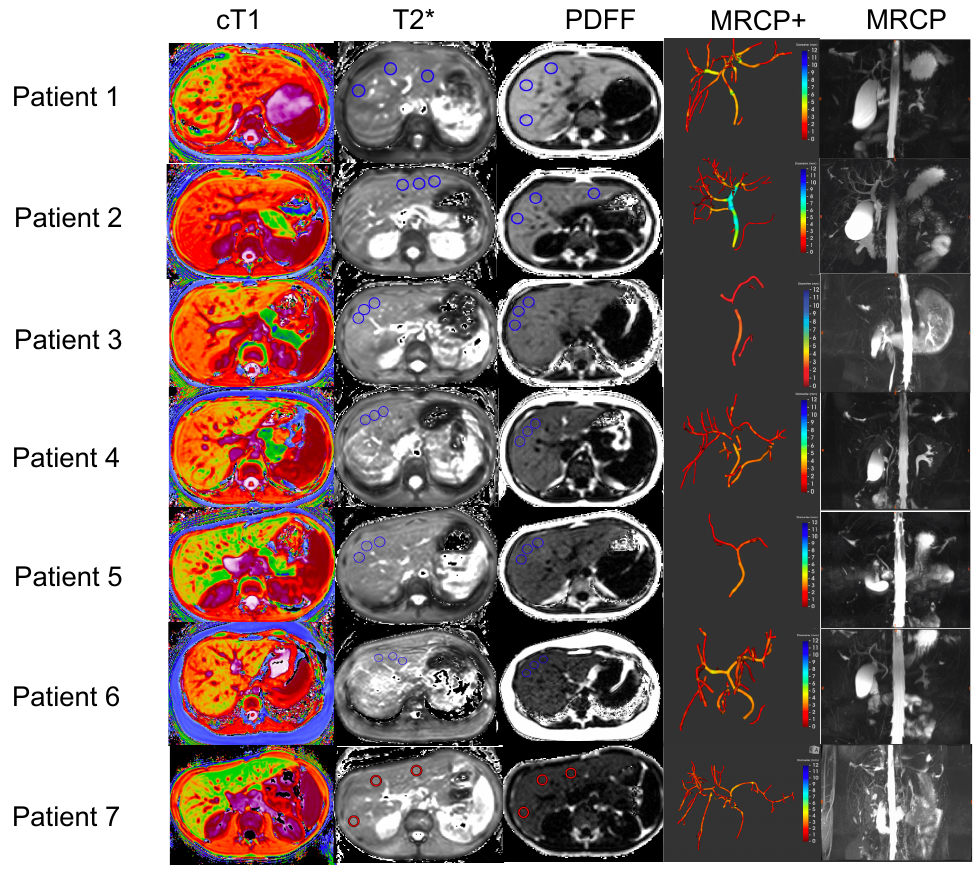
Figure 1. Representative biliary tree models, and cT1, T2*, and PDFF maps from all Wilson’s disease patients recruited in this study. In addition, the MRCP+ models of the biliary tree and the original MRCP images are also shown for each patient. In the cT1 maps, lower values (cooler colors) represent areas with lower cT1 values, and therefore, lower fibro − inflammation, whereas higher cT1 values (warmer colors) represent areas of the liver with higher fibro − inflammation. In the MRCP+ images, strictures are shown in red, whereas dilatations are shown in blue. cT1: corrected T1; PDFF: proton density fraction (MRI liver fat); magnetic resonance cholangiopancreatography (MRCP); quantitative magnetic resonance cholangiopancreatography